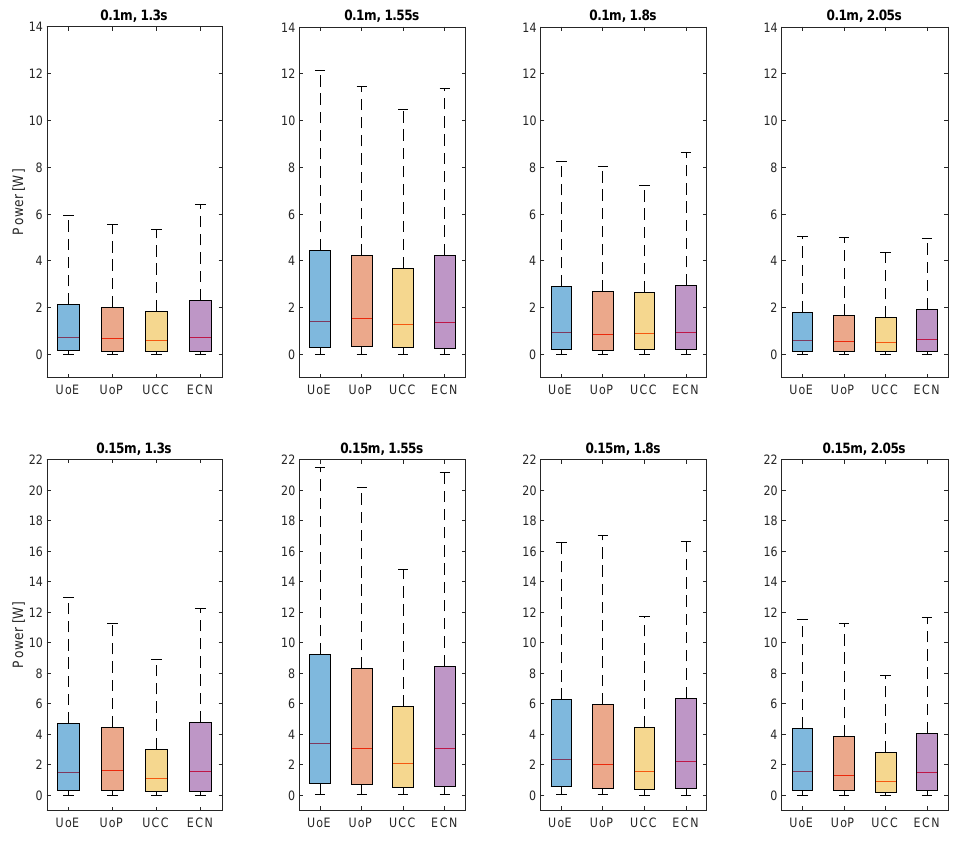
Figure 14. Median and interquartile range raft power for all sea states. Boxplot whiskers represent the 5th and 95th quantiles.